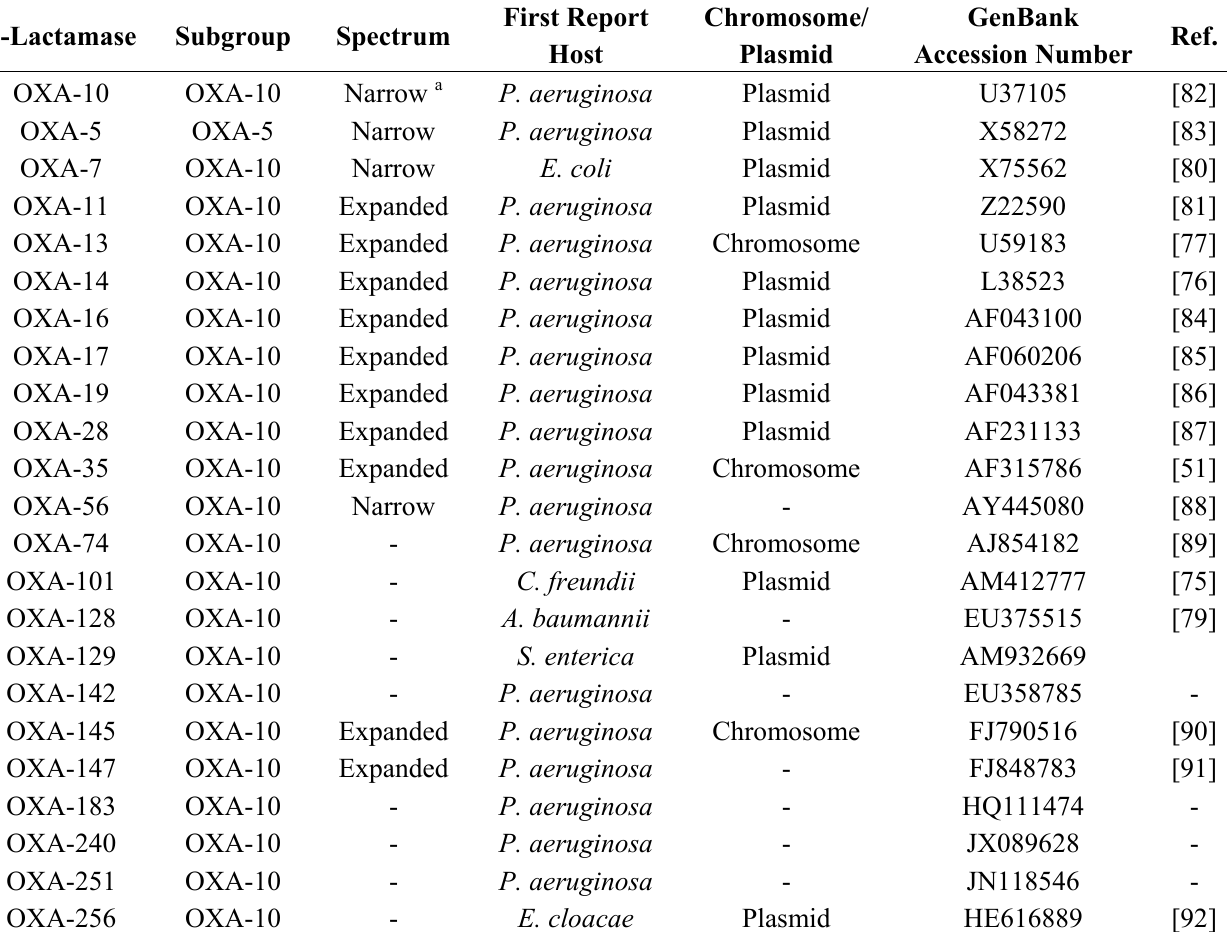
Table 9. OXA-10 like